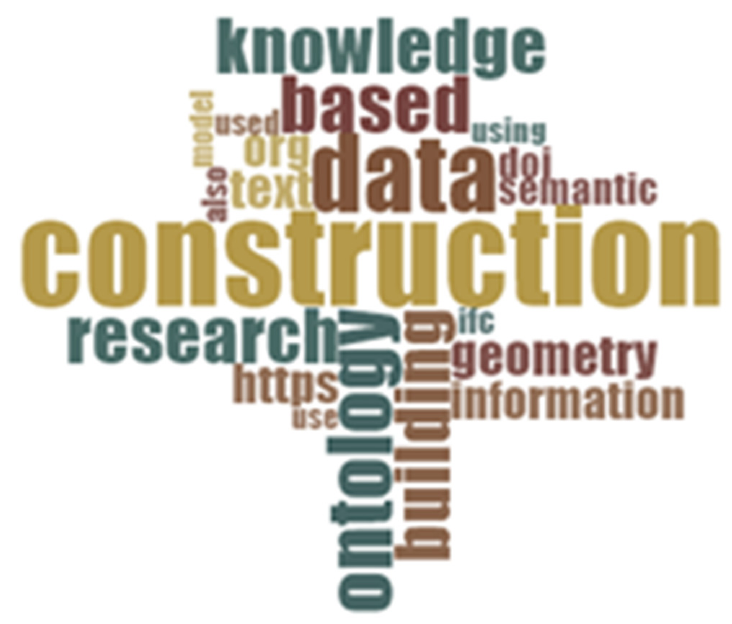
Figure 6. Visualization of keywords occurrences of construction related ontology use.